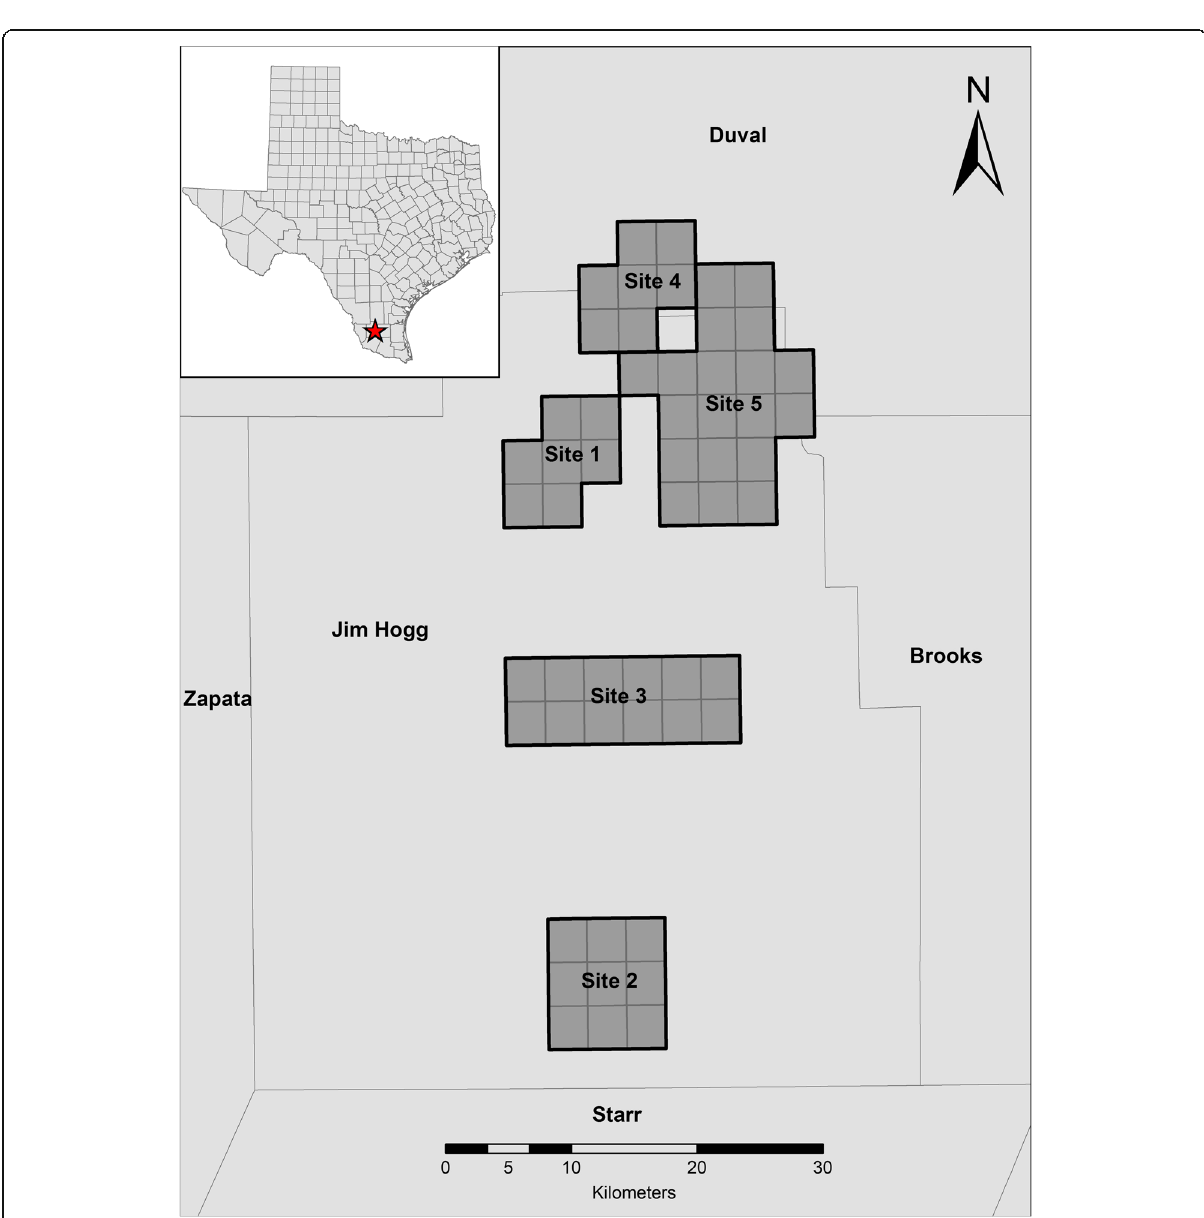
Fig. 1 Location of five sites in Jim Hogg and Duval Counties in the Coastal Sand Sheet of South Texas, USA. The dark gray areas with thick boundaries represent areas covered by NAIP aerial imagery (digital orthophoto quarter quads) for each respective study site. The thin black lines outside the sites represent the county boundaries of Jim Hogg, Duval, Zapata, Brooks, and Starr counties, Texas,